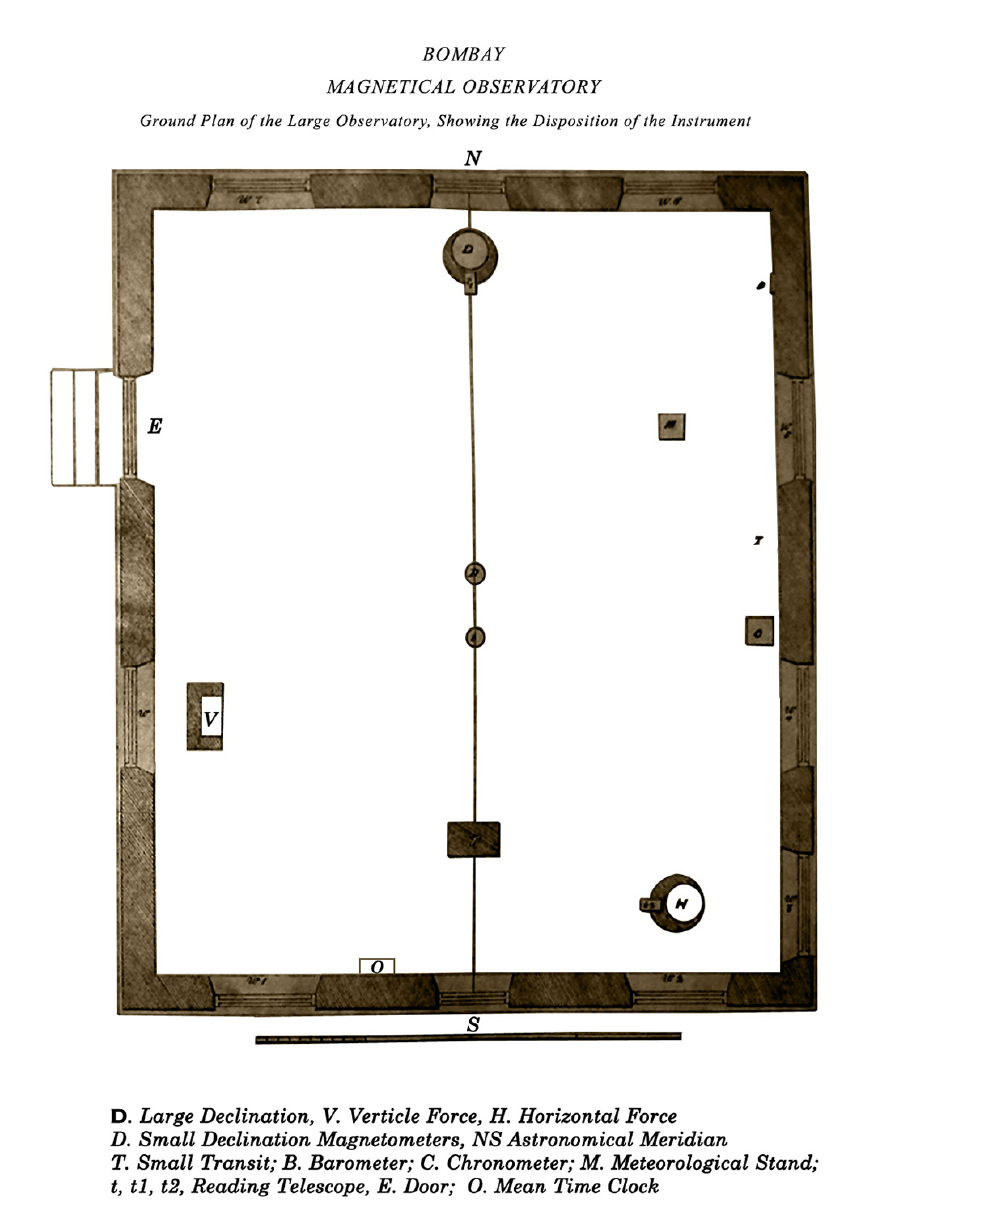
Figure 6. The placement of different instruments is depicted in this plan of the large observatory (Orlebar, 1846).